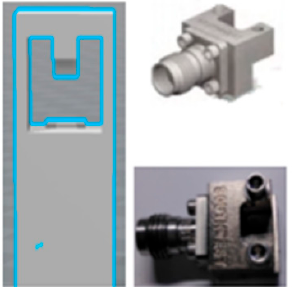
Figure 1. Connector Bracket and Figure 1. connector Bracket and connector.